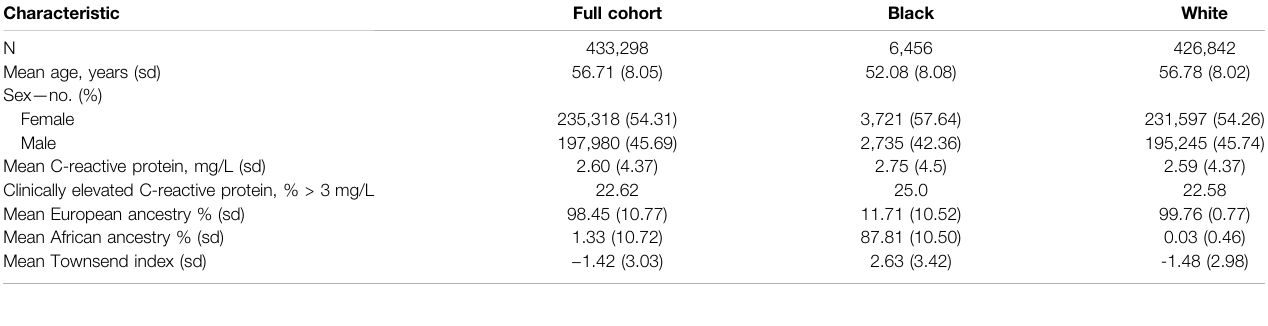
TABLE 1 | Characteristics of the United Kingdom Biobank participant cohort. Characteristic